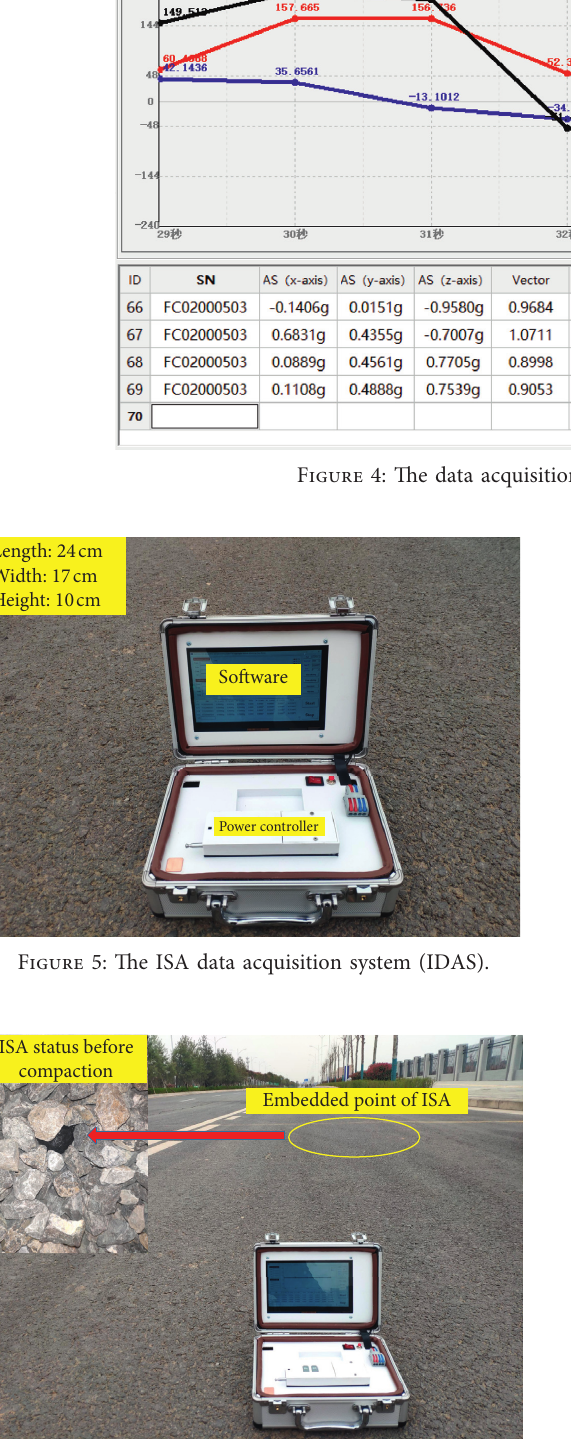
Figure 6: Signal transmission performance test of